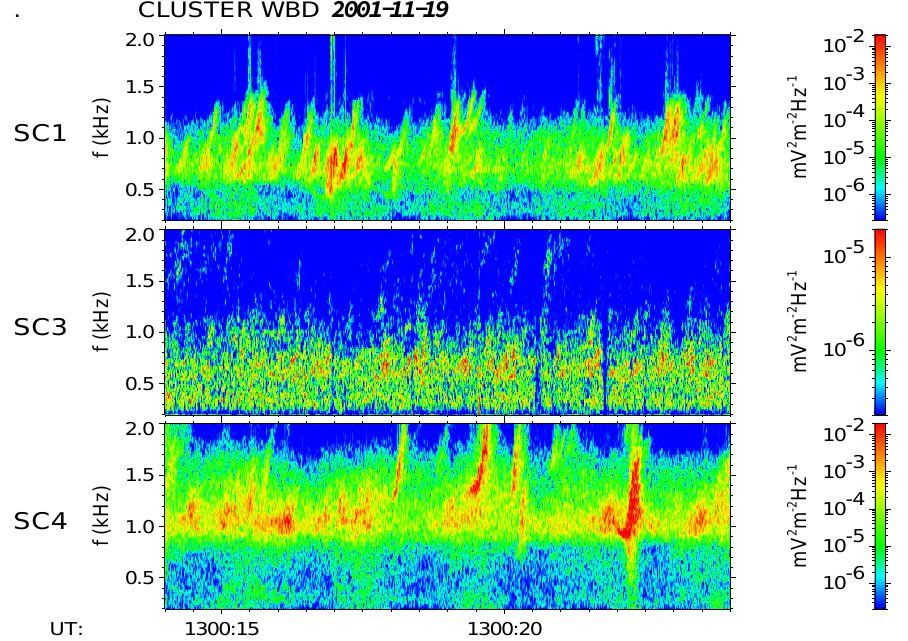
Fig. 5. Spectrograms of one electric component recorded by WBD on 19 November 2001 between 13:00:14 and 13:00:24UT for SC1 (top), SC3 (middle) and SC4